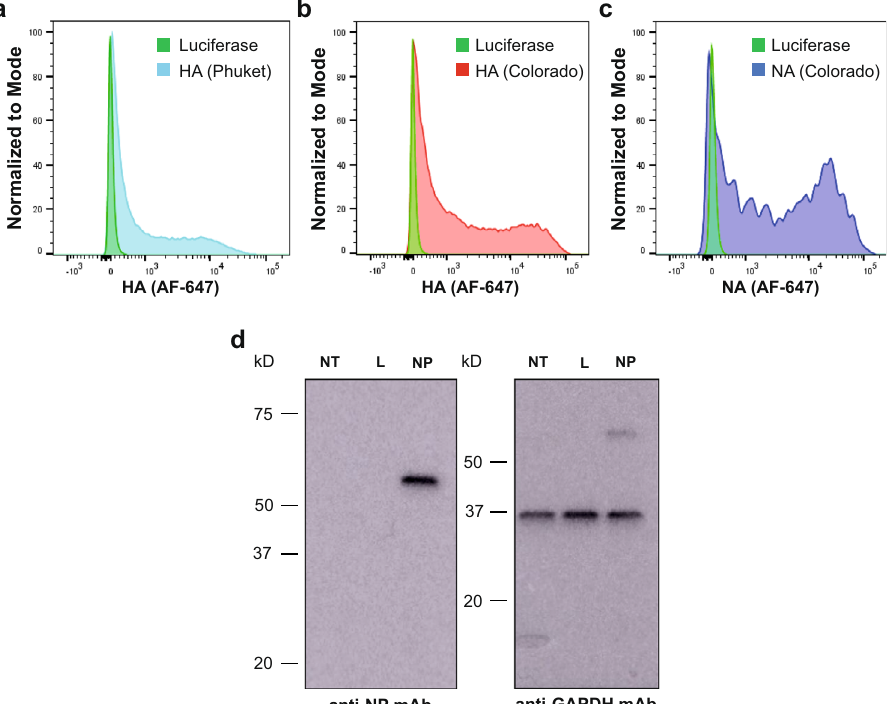
Fig. 1 | Characterization of antigen-encoding mRNAs by fl ow cytometry or Westernblot. HEK293TcellsweretransfectedwithHA-,NA-orluciferasecontrol- encoding mRNAs and protein production from each in fl uenza virus antigen- encodingmRNAwasassessedvia fl owcytometry.Positivebindingoftheantibodies speci fi c for B/Phu HA ( a ), B/Col HA ( b ), and B/Col NA ( c ) relative to luciferase